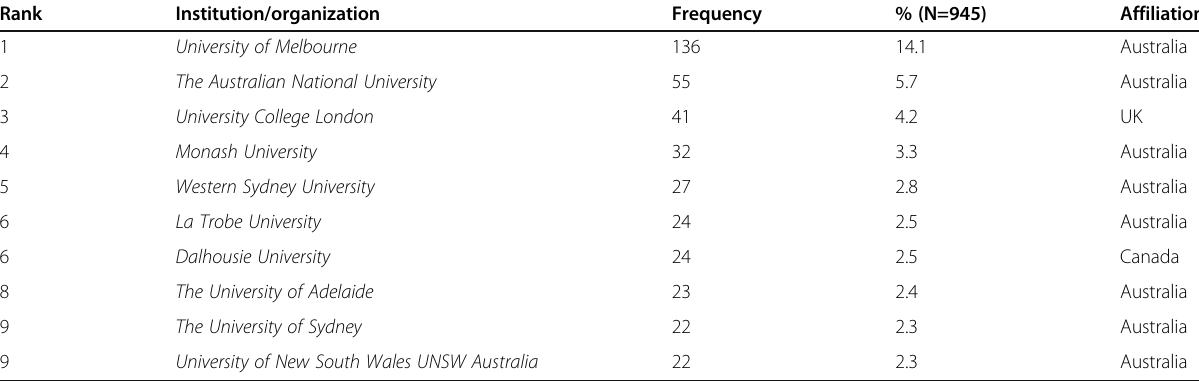
Table 5 Top ten active authors in publishing research documents on mental health